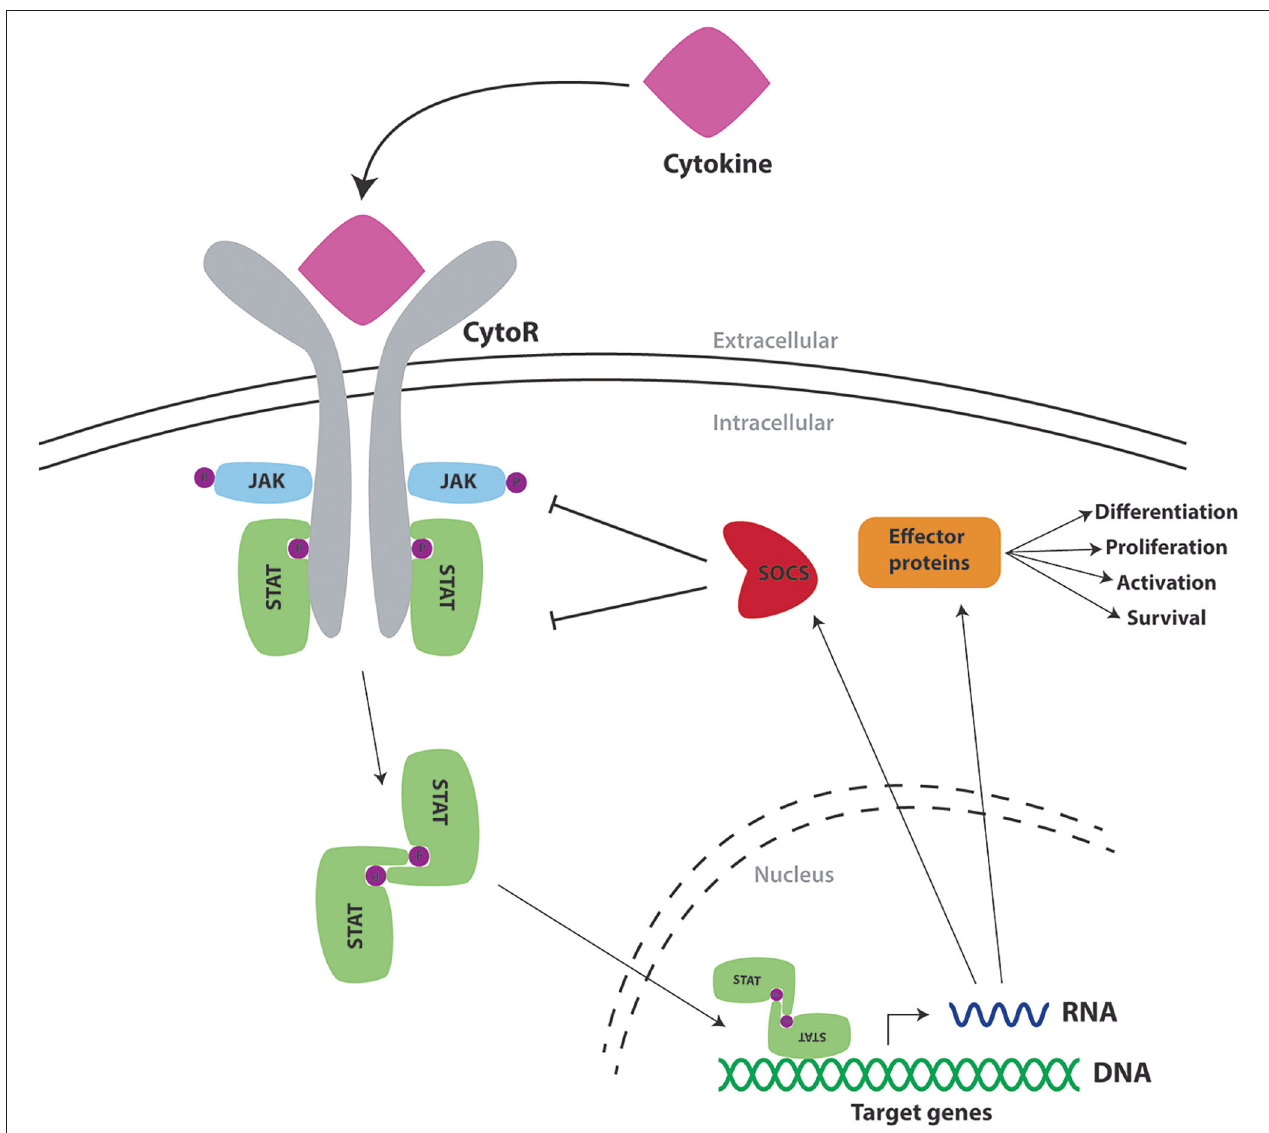
FIGURE 1 | Cytokine signaling via the JAK/STAT pathway and its regulation by SOCS proteins. Schematic representation of a cytokine (pink) binding to the extracellular portion of its cognate cytokine receptor (CytoR—gray), to cause activation of associated intracellular Janus kinases (JAK—blue), which mediate phosphorylation (P—purple) of tyrosine residues found on components of the receptor complex. These form docking sites for signal transducer and activator of transcription proteins (STAT—green), which also undergo phosphorylation to form STAT dimers. These translocate into the nucleus to activate transcription of target genes encoding effector proteins (orange) as well as SOCS proteins (red) that provide negative feedback